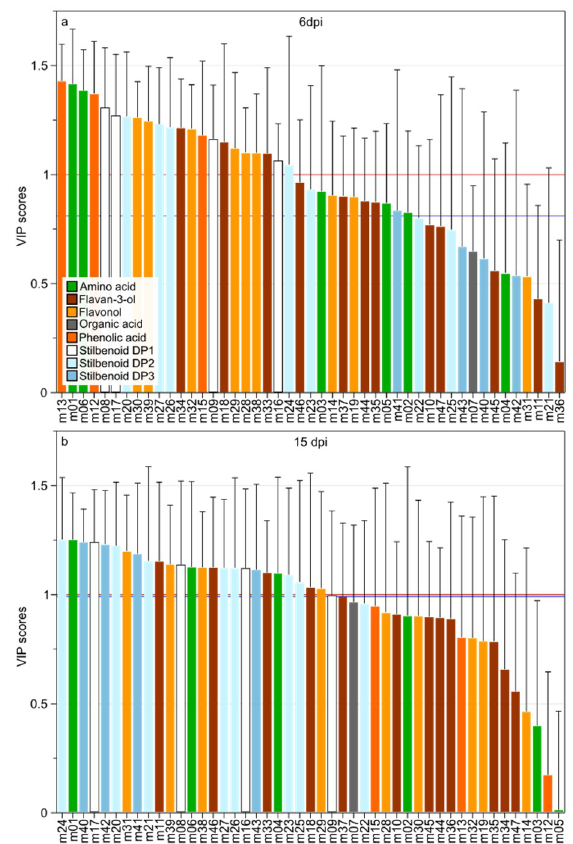
Figure 4. VIP-scores of the OPLS-DA models performed on oil spots symptomatic leaves data (6 dpi; a) and on necrotic symptomatic leaves (15 dpi; b) with a cutoff level of VIP > 1 (red lines) or depending on non-parametric statistical analysis (blue lines; 6 dpi = 0.81; 15 dpi = 0.99). Each variable was colored according to the polyphenol class and numbers indicated the ID of the compound as given in the